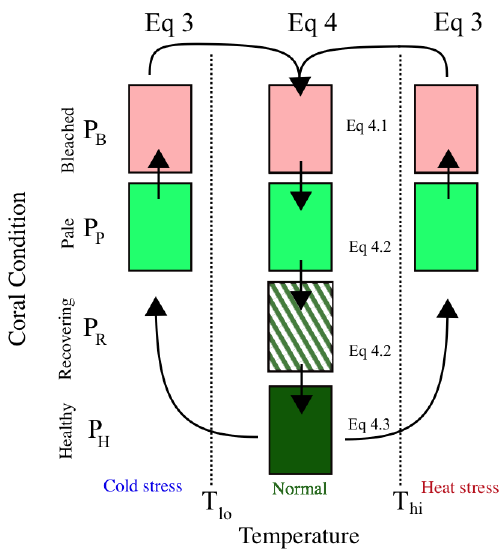
Figure 2. The four states of coral physiological health status in the model (healthy, recovering, pale, and bleached). The transitions be- tween the four states are represented by arrows, and the size of the arrow gives an indication of the relative rates of the